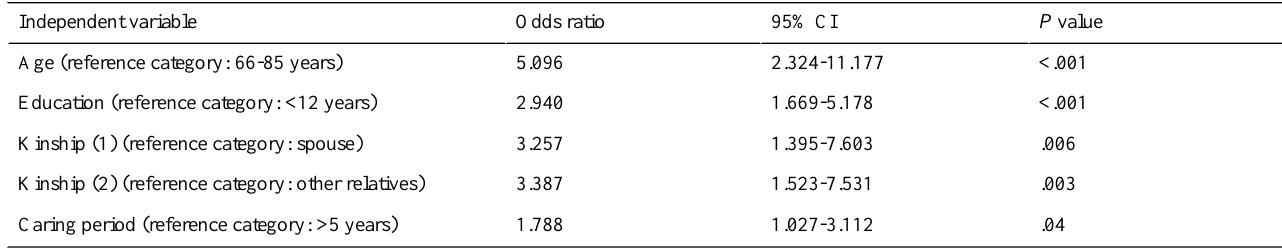
Table 3. Predictors of internet use based on binary logistic